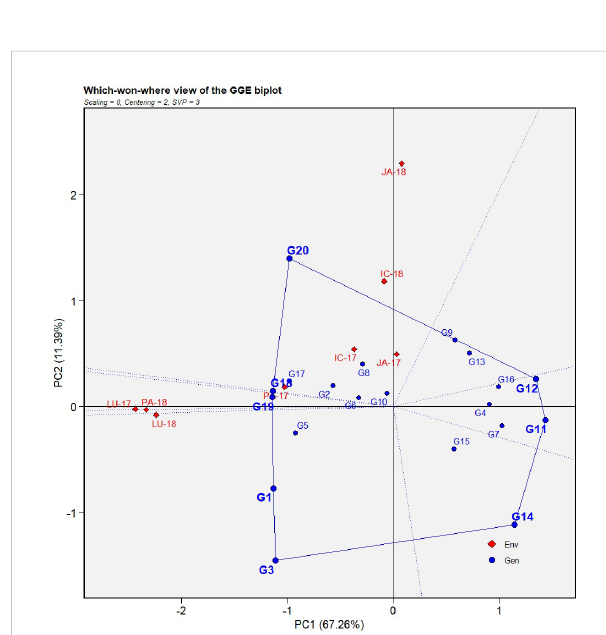
FIGURE 4 Which-won-where view of GGE biplot of IABN against AB severity across four locations during 2 years. The data were centered through environments (centering = 2) without scaling (scaling = 0). Locations are denoted as IC- (ICRISAT), JA- (Jammu), LU- (Ludhiana), and PA- (Palampur). Years are denoted as -17 (year 2017/ 2018) and -18 (year 2018/2019). IABN, International Ascochyta Blight Nursery; AB, Ascochyta